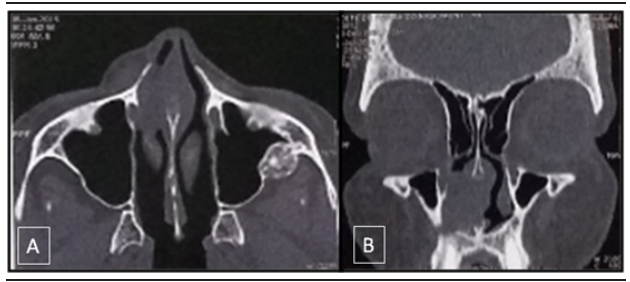
FIGURA 1 – Imagens de tomografia computadorizada Imagens em corte axial (A) e coronal (B) evidenciando a lesão